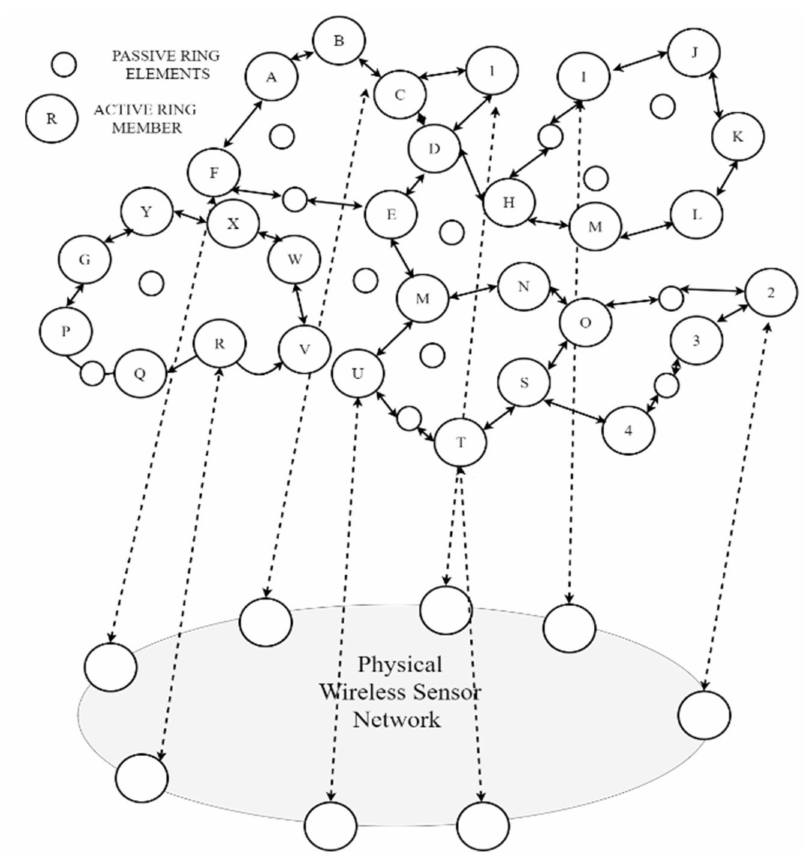
Figure 10. Ring Overlay